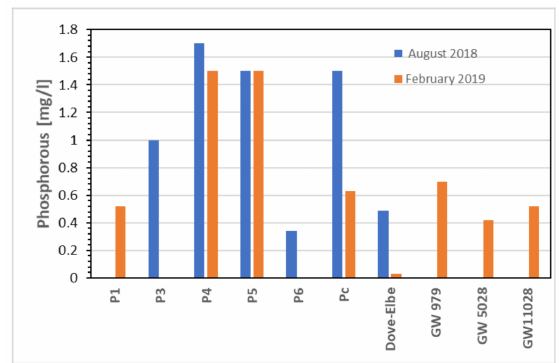
Figure 12. Phosphorous concentrations in push-point samples, the Dove-Elbe, and in groundwater.